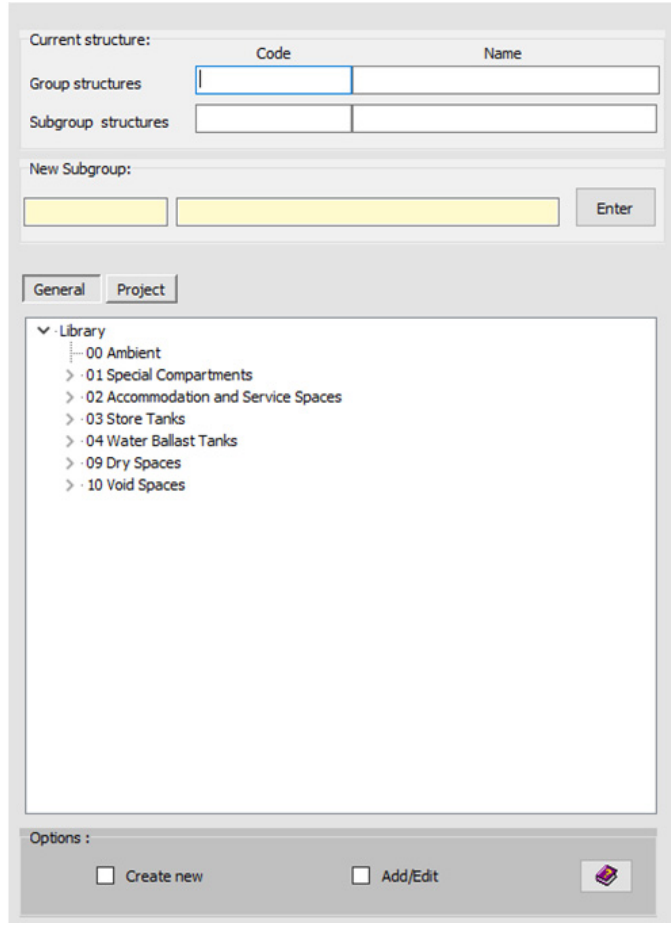
Figure 10. Top-level directory (compartments groups). Table 1. Classification of the ship compartments/tanks.